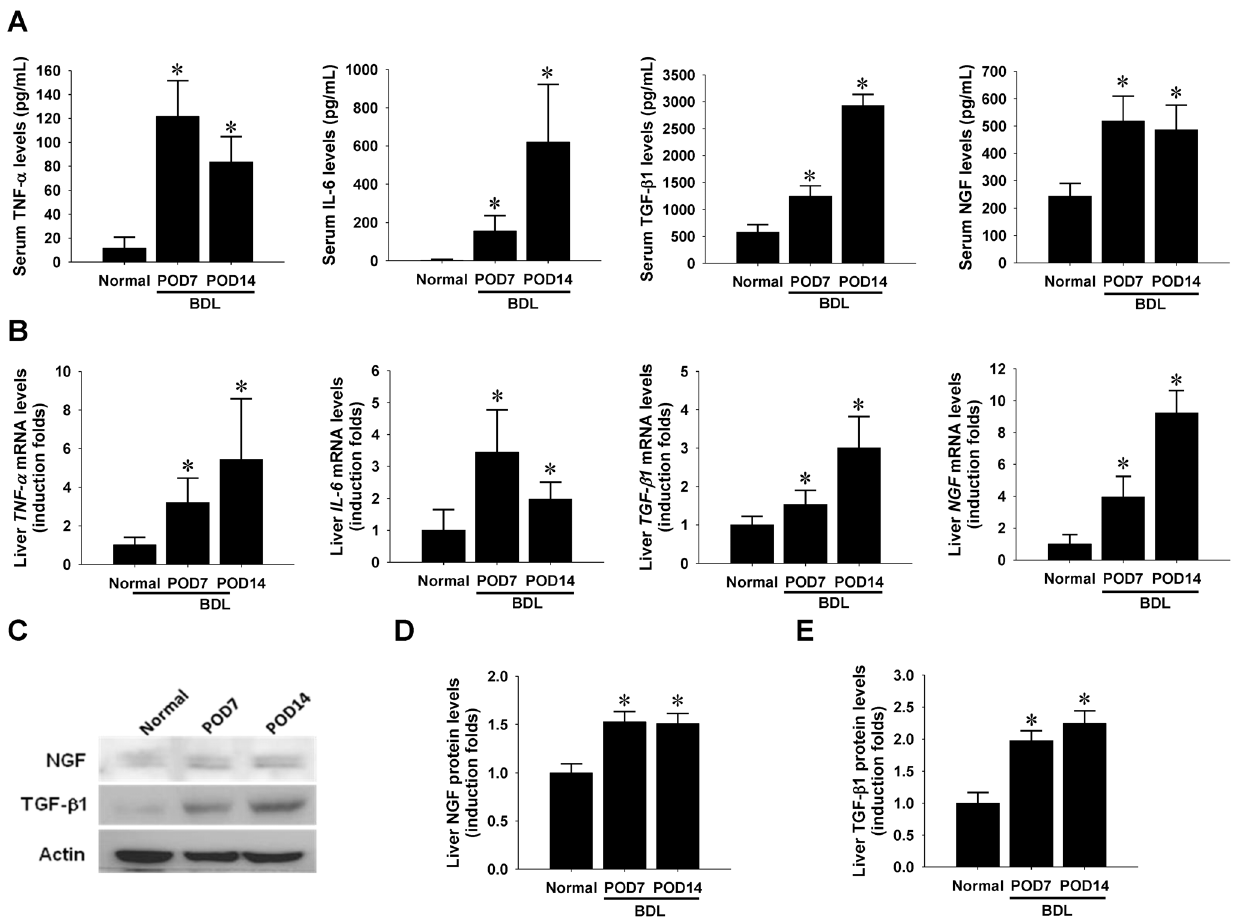
Figure 1. Increased serum NGF levels and intrahepatic NGF up-regulation in mice receiving bile duct ligation (BDL) surgery. Normal mice (n=6) and those receiving BDL surgery were sacrificed at 7 or 14 post-operative days (POD7, n=4) or (POD14, n=4). (A) Serum levels of NGF and inflammatory cytokines, including TNF- a , IL-6 and TGF- b 1 were determined by ELISA detection. (B) Liver tissue extracts were collected for mRNA isolation and subjected to RT-qPCR analysis. (C) Contents of NGF and TGF- b 1 proteins in pooled liver extracts in experimental groups were measured using Western blot detection. Subsequent densitometrical analysis showed that cholestatic injury increased protein abundance of NGF (D) and TGF- b 1 (E). All data are shown in mean 6 SEM. * indicates P , 0.05 as compared to normal